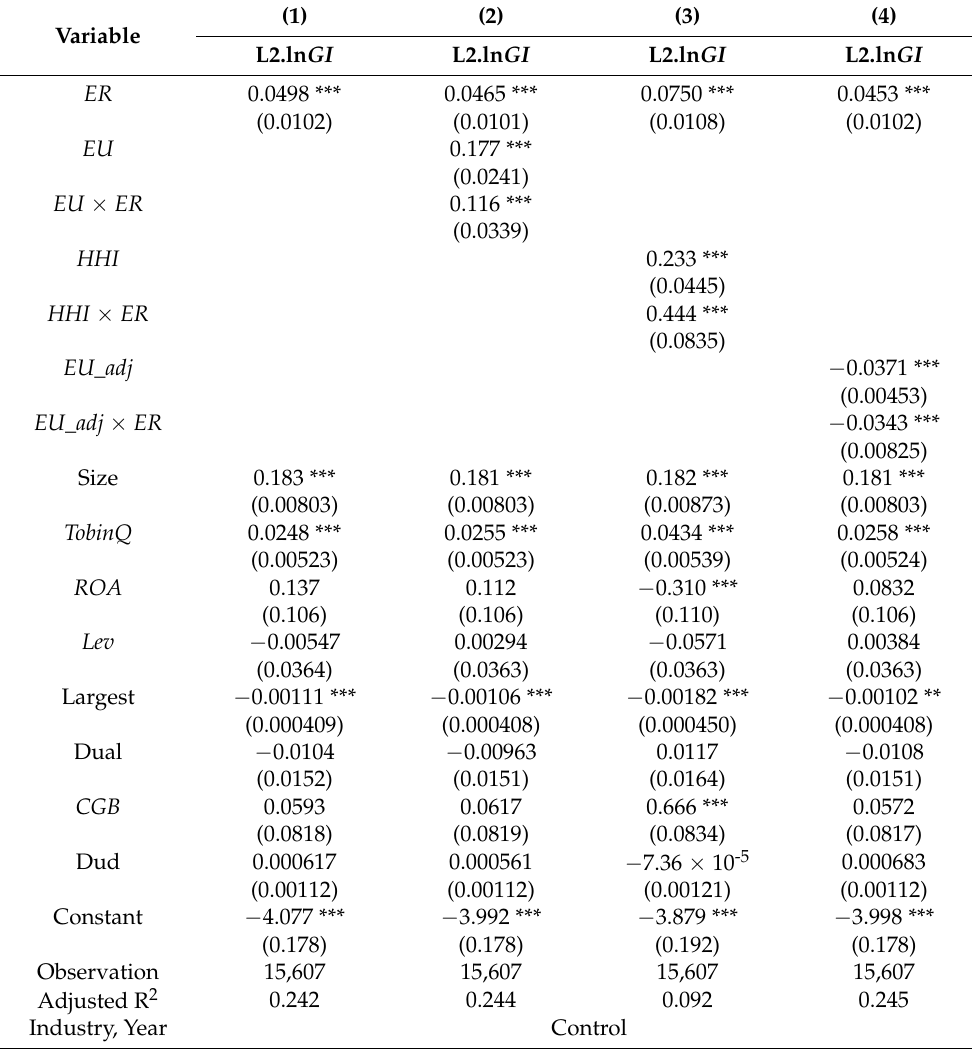
Table 14. The Regression Analysis of Environmental Uncertainty, Environmental Regulation and Enterprises’ Green Technological Innovation Lagging Two